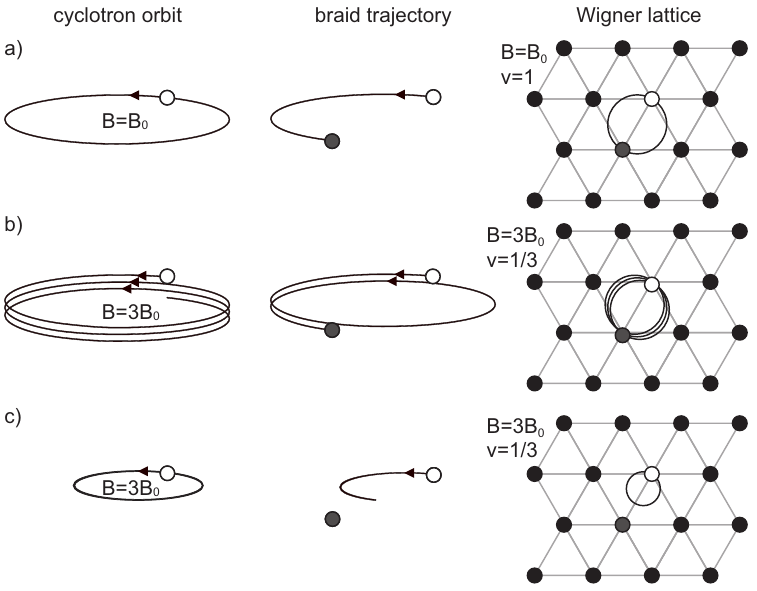
Figure 2. ( a ) left panel—a single-loop cyclotron orbit is schematically presented together with the corresponding braid generator σ j of the full braid group (central panel)— its metrics perfectly fits at ν = 1 to the separation of interacting electrons in the Wigner lattice on the plane (right panel). ( b ) left panel—three-loop cyclotron orbit for a three-times larger magnetic field and the related generator of cyclotron braid group σ 3 (central panel)—its metrics also perfectly fit at ν = 1 to the electron 3 j separation in the Wigner lattice (right panel); ( c ) a visualization that the small single-loop cyclotron orbits for the field three times larger than in the case of ( a ) i.e., at at ν = 1 preclude the definition of 3 braids σ j (such braids cannot reach even the closest electrons in the Wigner lattice (right panel)). We see that the IQHE state is the correlated state of electrons according to the full braid group homotopy pattern (1) and this is not equivalent with only an integer filling rate of LLs (here, the LLL). Complete filling of LLs can also happen in gaseous systems without interaction, but is not protected there by any homotopy invariant in contrast to